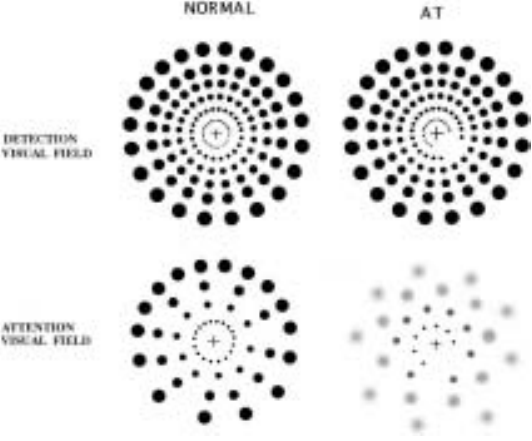
Fig. 7. A schematic representation of the sensory versus atten- tional visual field in normal subjects and AT (after Intrilligator & Cavanagh [13]). The sensory visual field was almost normal while the attentional visual field seemed severely